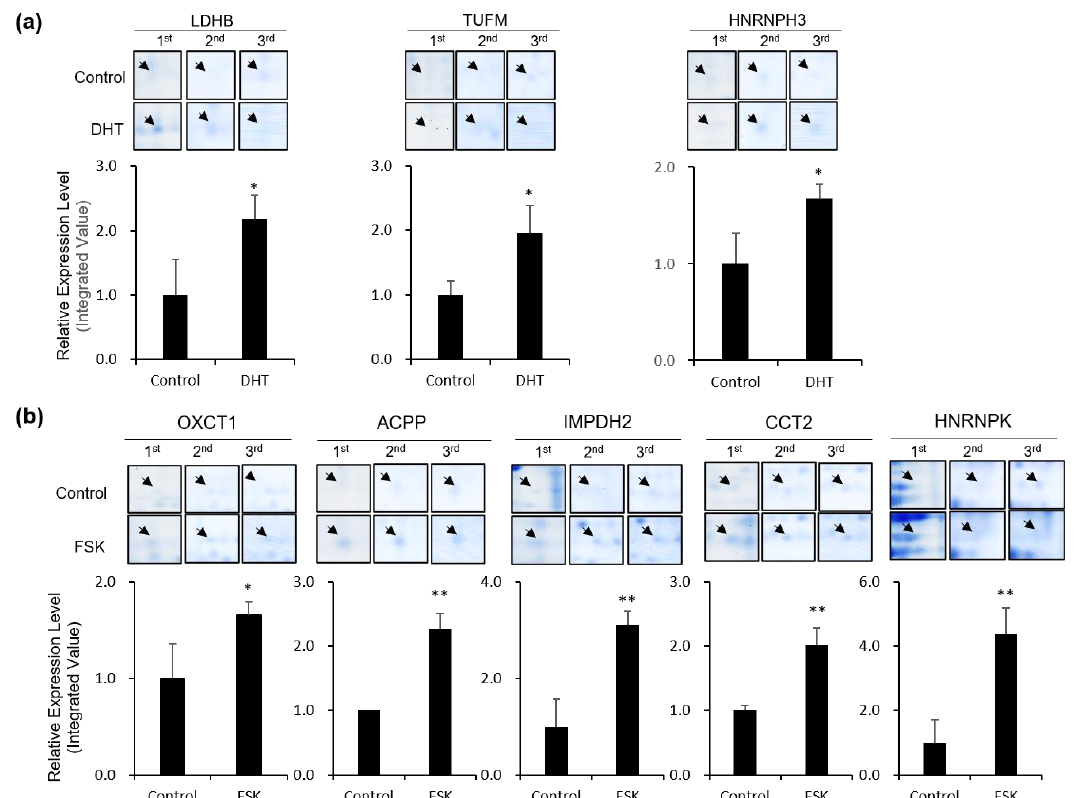
Figure 2. Comparative expression levels of the identified protein spots. Protein spots and the relative expression levels of proteins regulated by DHT ( a ) and FSK ( b ) from 2DE analysis. Significantly regulated proteins exhibiting between-group changes of 1.5-fold or more (* p < 0.05, ** p < 0.01) are presented. The values were calculated based on spot densities obtained using PDQuest. The data obtained from the mean ± standard deviation (SD) of three independent experiments are presented as fold changes.